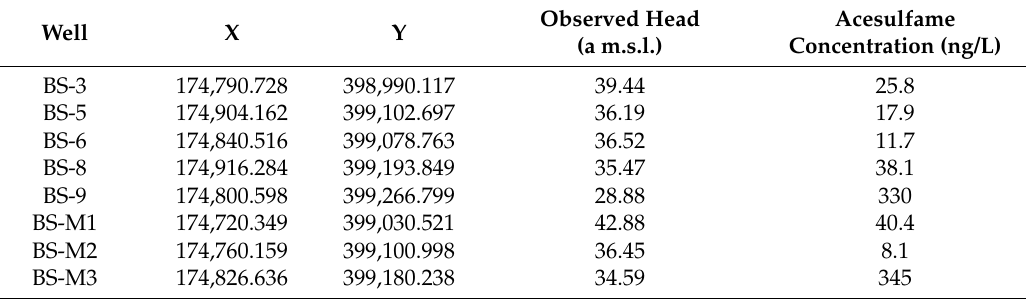
Table 10. The well locations, groundwater levels, and acesulfame concentrations.